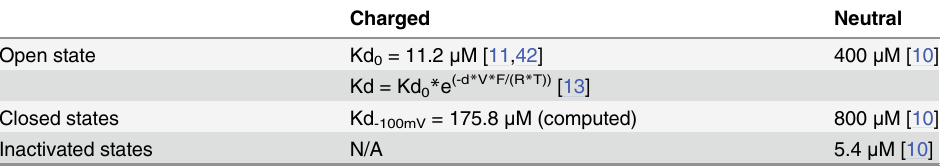
Table 3. Model State Specific Affinities of Drug to the Sodium Channel Flecainide. Charged Neutral Open state Kd 0 = 11.2 μ M [11,42] 400 μ M [10] Closed states Kd -100mV = 175.8 μ M (computed) 800 μ M [10] Inactivated states N/A 5.4 μ M [10] d = fractional electrical charge = 0.7; F = Faraday ’ s constant = 96485.3415; R = Universal gas constant = 8314.472; T = Temperature (in K) = 295 for optimization; Kd 0 = Kd at 0mV (measured af fi nity